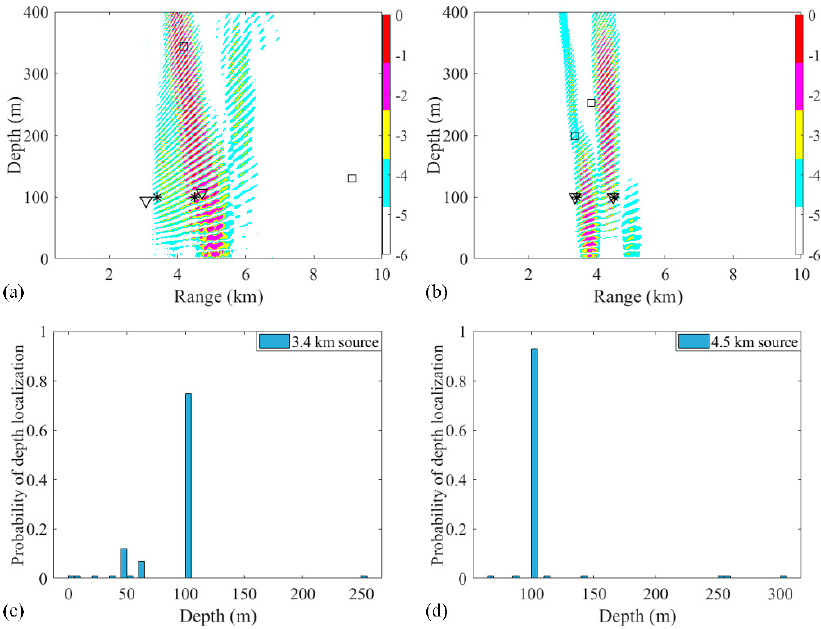
Figure 16. Ambiguity surfaces generated by ( a ) the experimental data and ( b ) the simulated data using the RAMPMF method to localize sources (3.4 km, 100 m) and (4.5 km, 100 m). True source positions and the positions estimated by the RAMP and RAMPMF methods are represented as black asterisks, squares, and inverted triangles, respectively. The depth distributions in 500 realizations of simulated data for ( c ) 3.4 km and ( d ) 4.5 km sources.